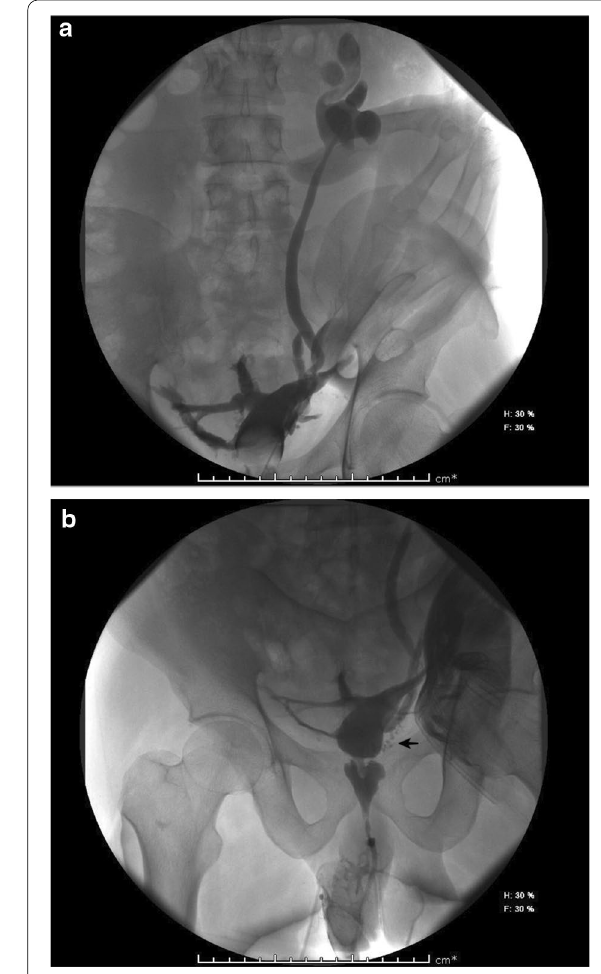
Fig. 2 MCUG images. a Filling phase showing the distorted small bladder with multiple sinus tracts leading to the abdomen with grade III reflux on left side. b Voiding phase showing the dilated distorted posterior urethra with intravasation into the left seminal vesical (shown by black arrow) and leak from urethrocutaneous fistula (shown by white